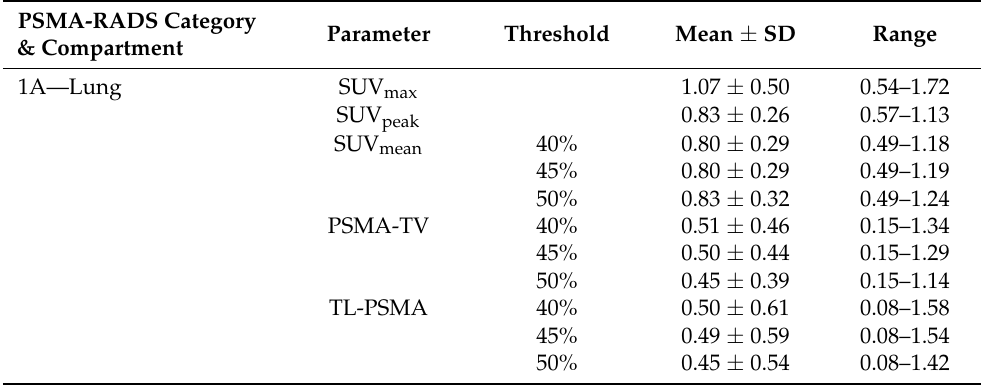
Table A1. Descriptive statistics of intensity of tracer uptake and volumetric 18 F-PSMA PET/CT parameters of all lesions separated by PSMA-RADS category and